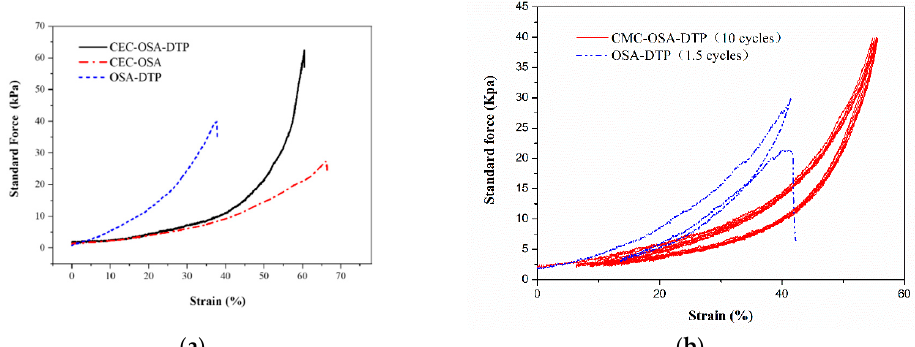
Figure 6. ( a ) Typical compressive stress-strain curves of hydrogels with different compositions. ( b ) Successive loading-unloading compressive tests of CMC-OSA-DTP hydrogel (10 cycles) and OSA-DTP hydrogel (1.5 cycles).